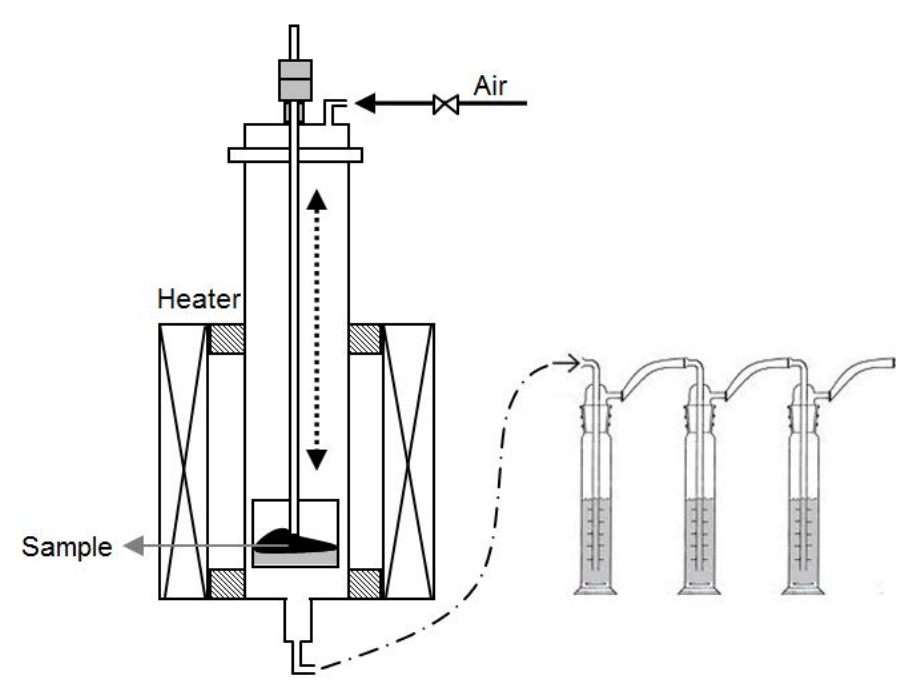
Figure 4. Combustion simulation